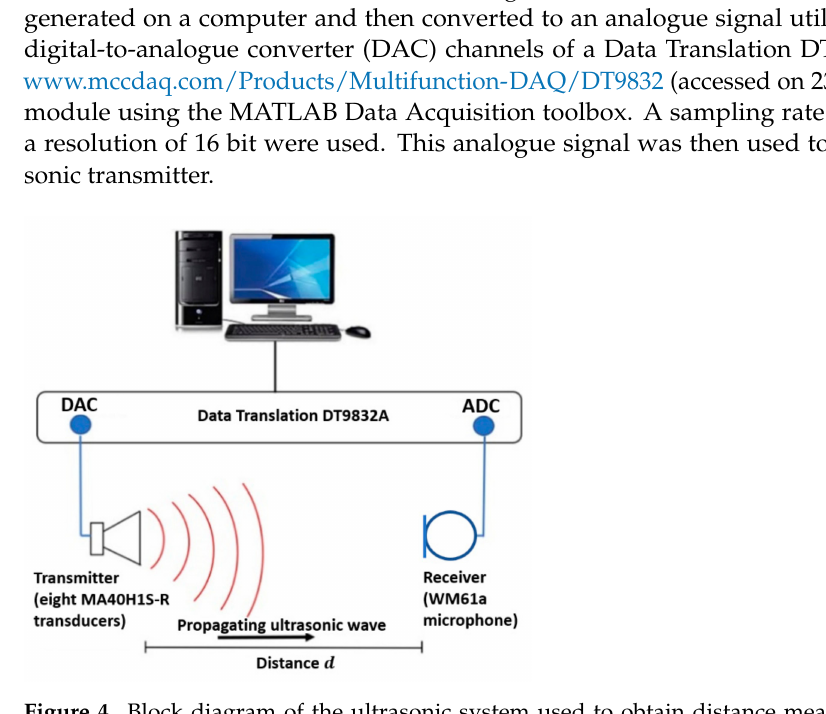
Figure 4. Block diagram of the ultrasonic system used to obtain distance measurements. DAC: digital-to-analogue converter; ADC: analogue-to-digital